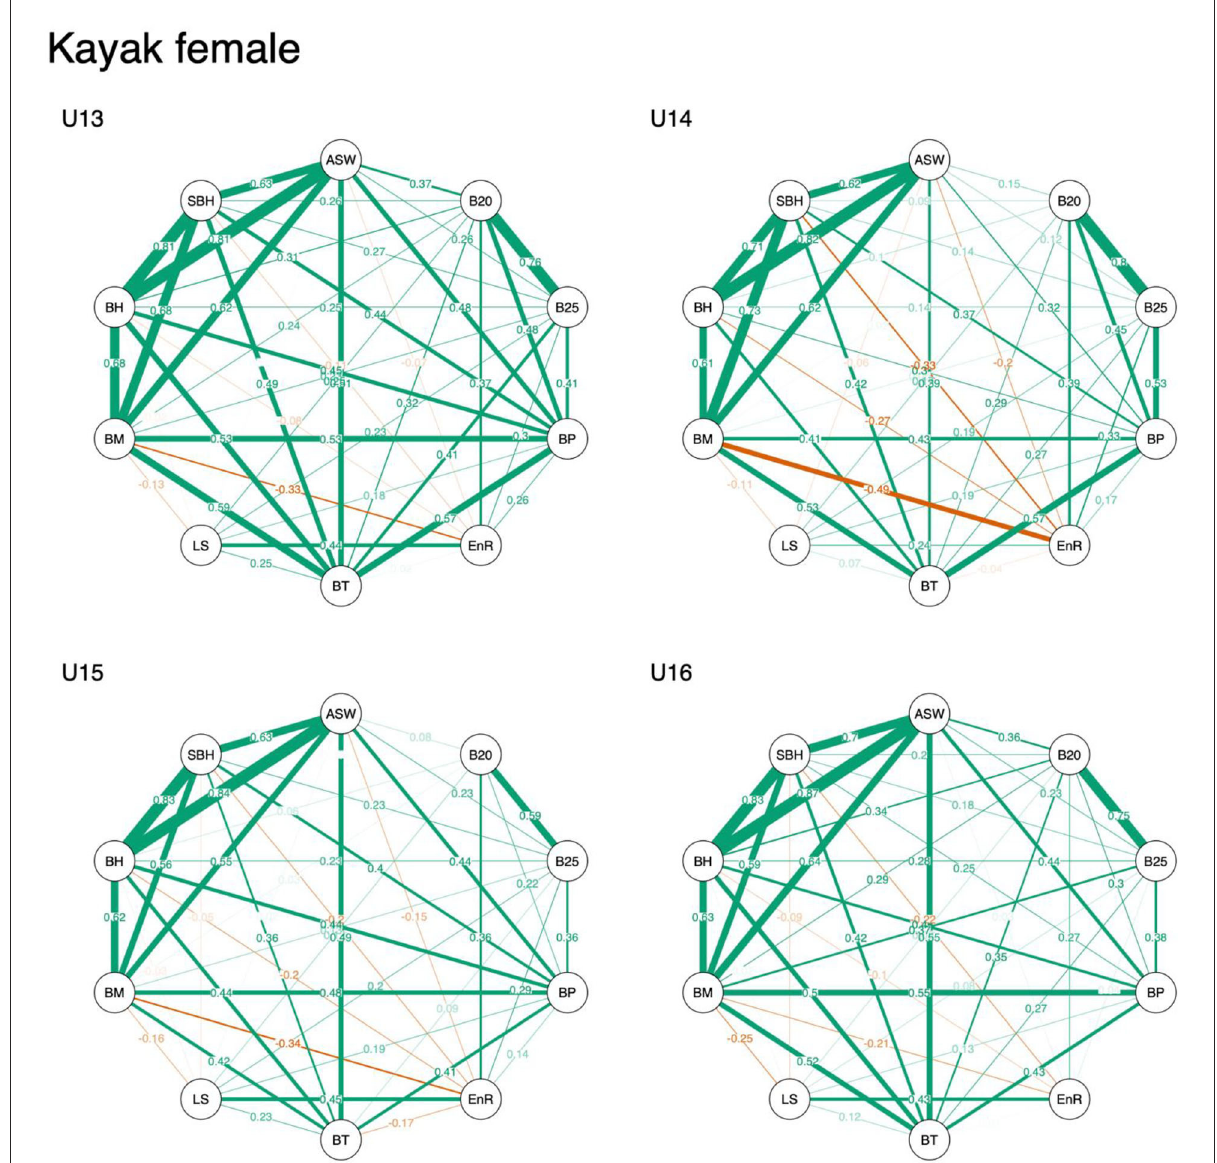
FIGURE1 Network representation of a correlation matrix of different test items of anthropometric, physical fitness, and sport-specific performance measures in young female kayakers. ASW, arm span width; B20, 2,000m on-water race; B25, 250m on-water race; BP, bench press and bench pull; EnR, 800m run; BT, underhand ball throw test; LS, 30m linear sprint; BM, body mass; BH, body height; SBH, sitting body